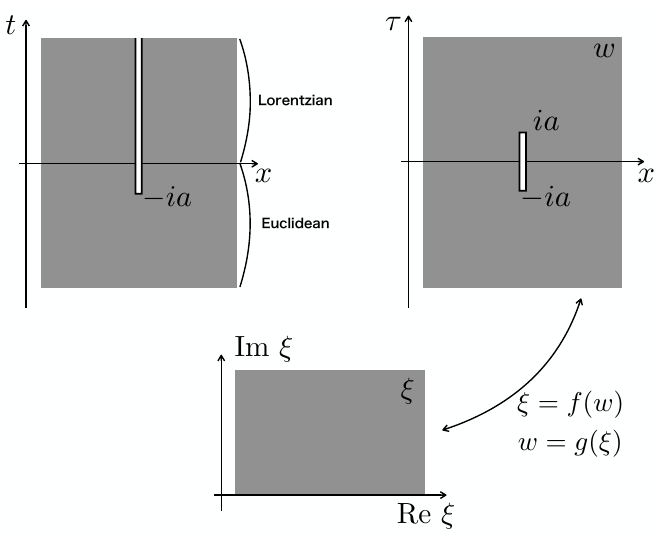
Figure 6 . The left figure shows how to realize a single splitting quench using path integral in a (1+1)d CFT. The right figure shows the corresponding Euclidean setup. It can be mapped into an upper half plane as showed in the lower figure using (2.27) or (2.28).